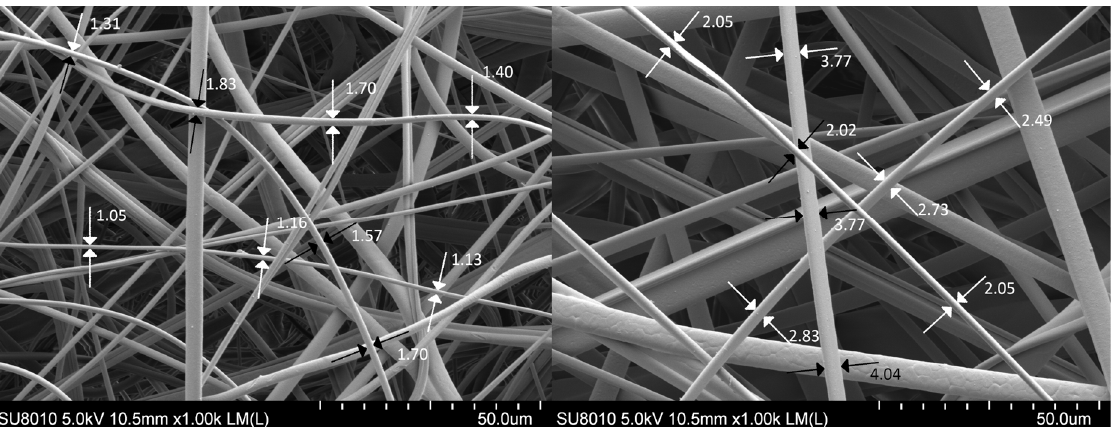
Figure 5. Example of the utilised measurement method for the ( left ) F1 filter and ( right ) F6 filter.